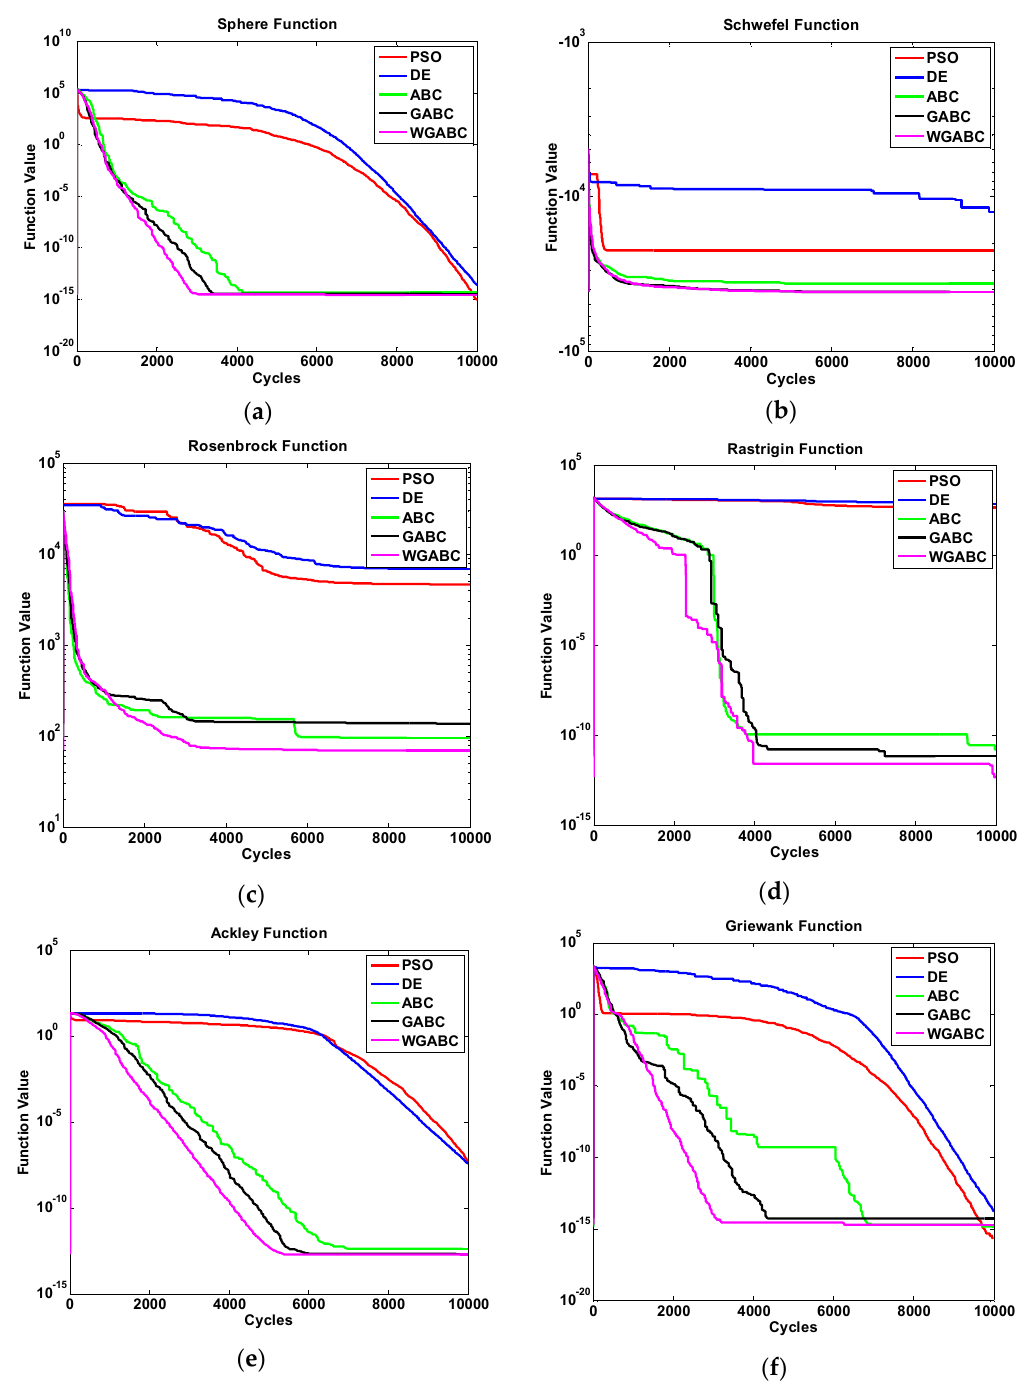
Figure 2. ( a ) The convergence speed diagram of Sphere function; ( b ) The convergence speed diagram of Schwefel function; ( c ) The convergence speed diagram of Rosenbrock function; ( d ) The convergence speed diagram of Rastrigin function; ( e ) The convergence speed diagram of Ackley function; ( f ) The convergence speed diagram of Griewank function.